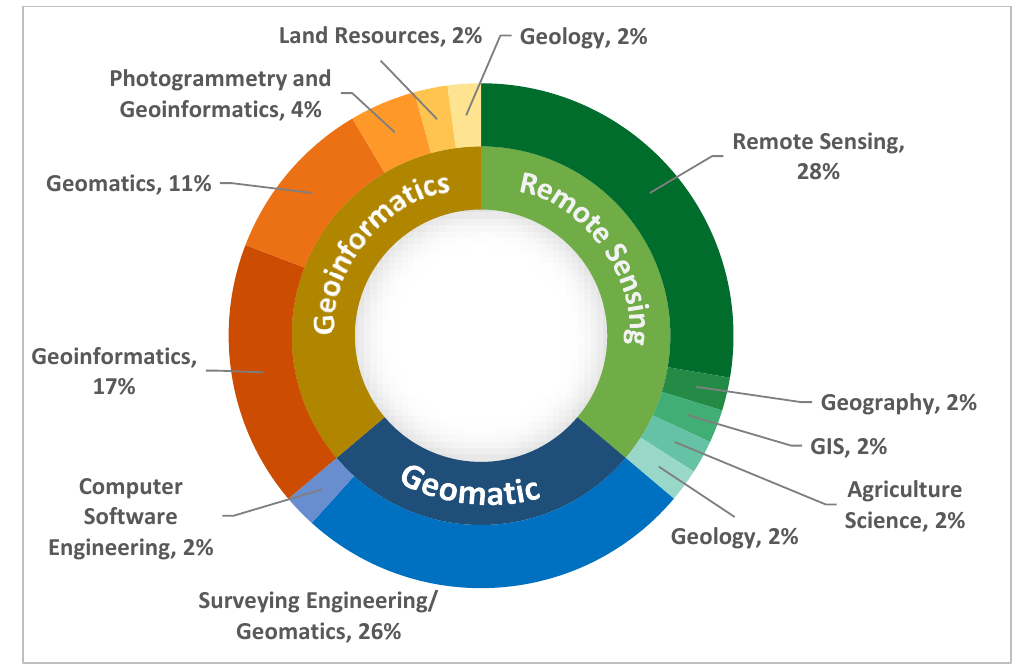
Figure 2. Entry qualification degree (FGHT-PG students 2010-2015)